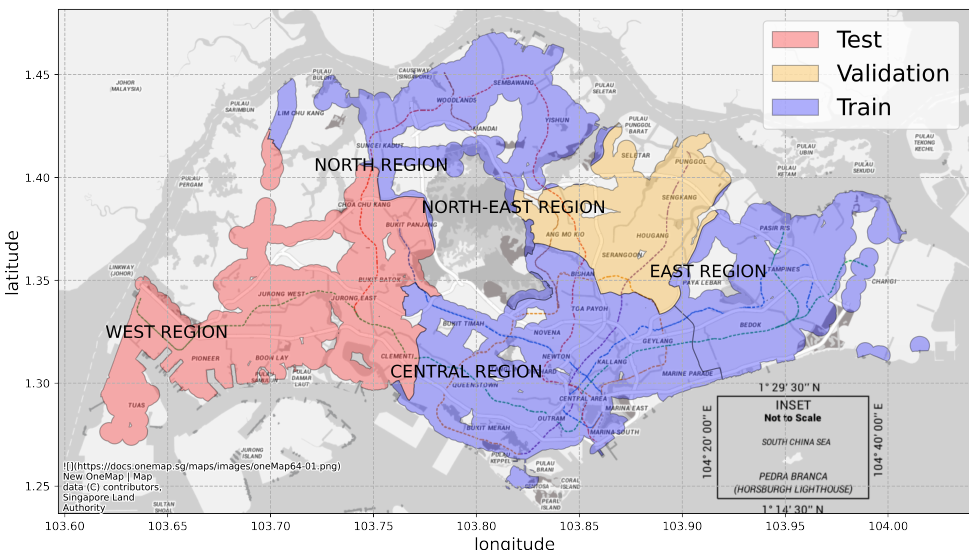
Figure 6. Nodes in the red area (West Region) are used for testing, nodes in the orange area (Northeast Region) are used for validation, and nodes in the blue area (North Region, East Region and Central Region) are used for training. Best viewed in